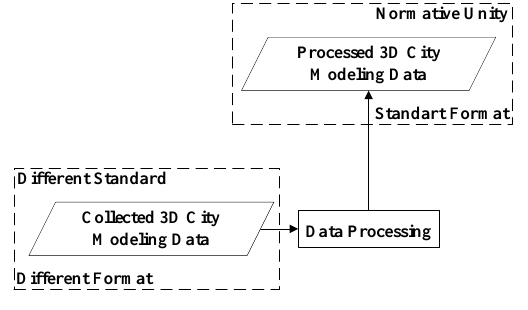
Figure 6 . Processed of 3D City Modeling Data